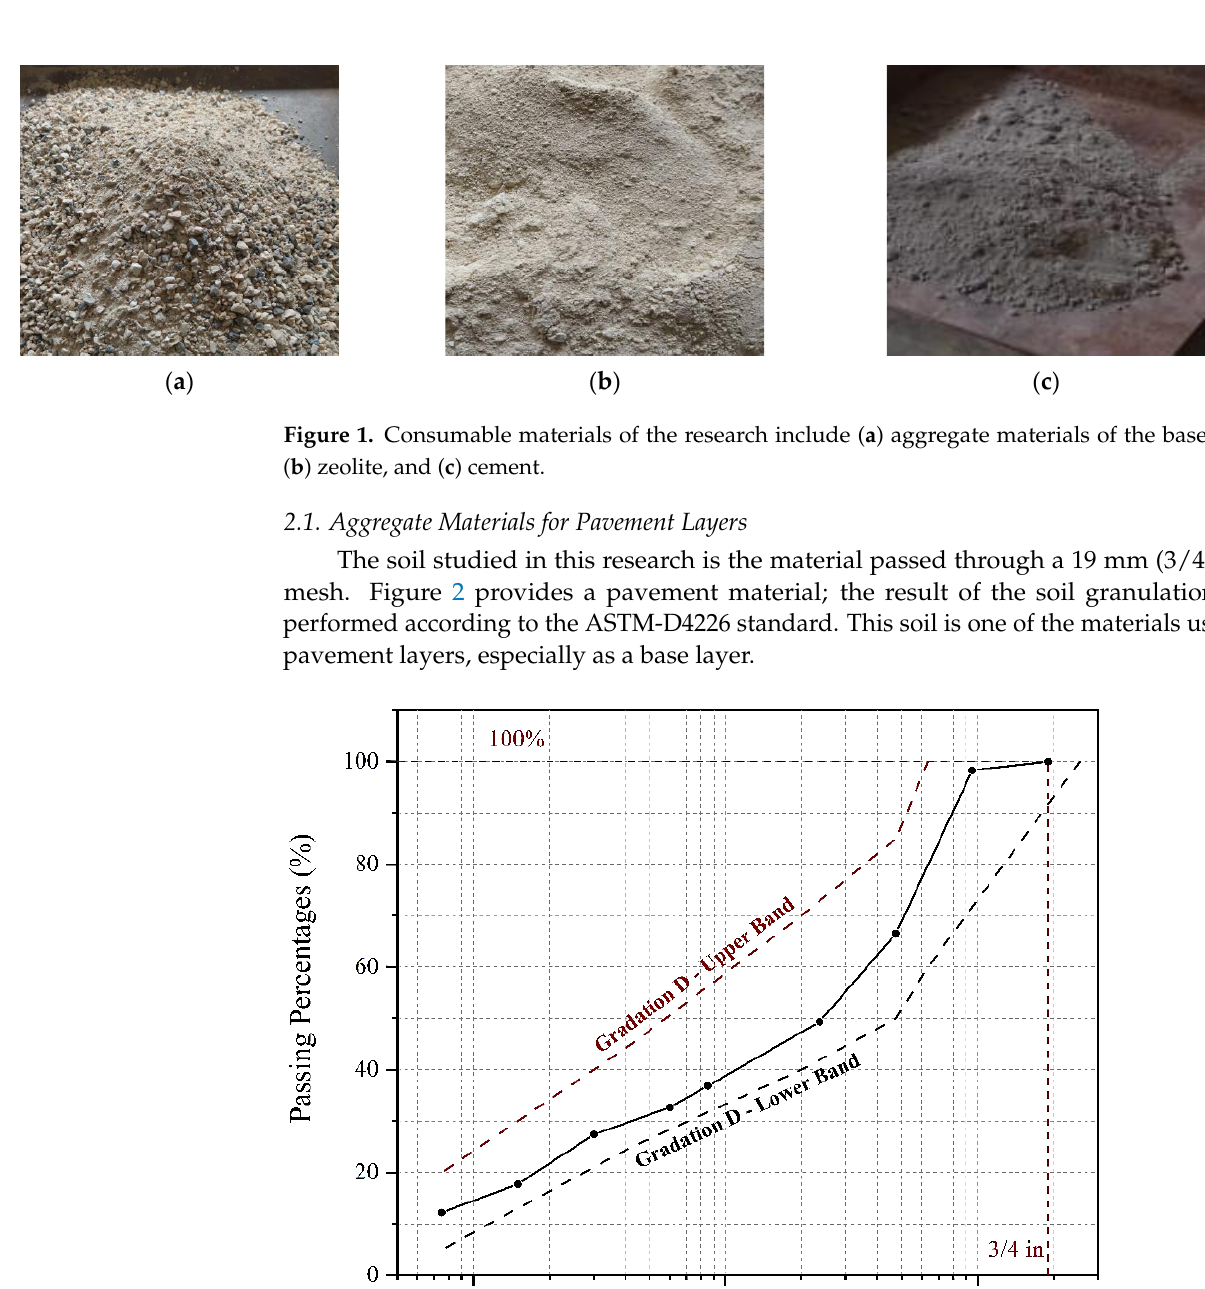
Figure 2. Granulation diagram of the studied soil.